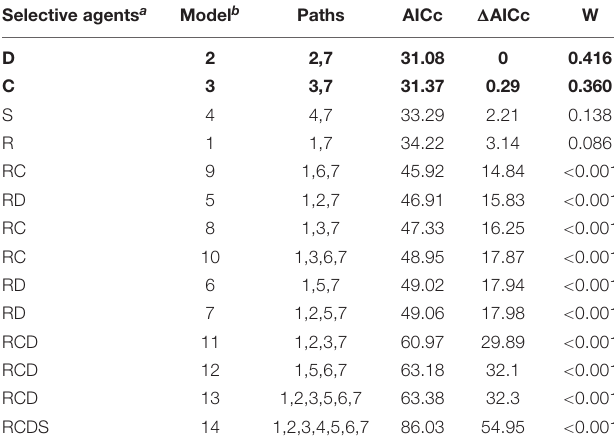
TABLE 5 | List of the a priori 14 candidate models of the effect of the four putative selective agents on the life-history suite with corresponding AICc values, (cid:49) AICc, and AICc weight